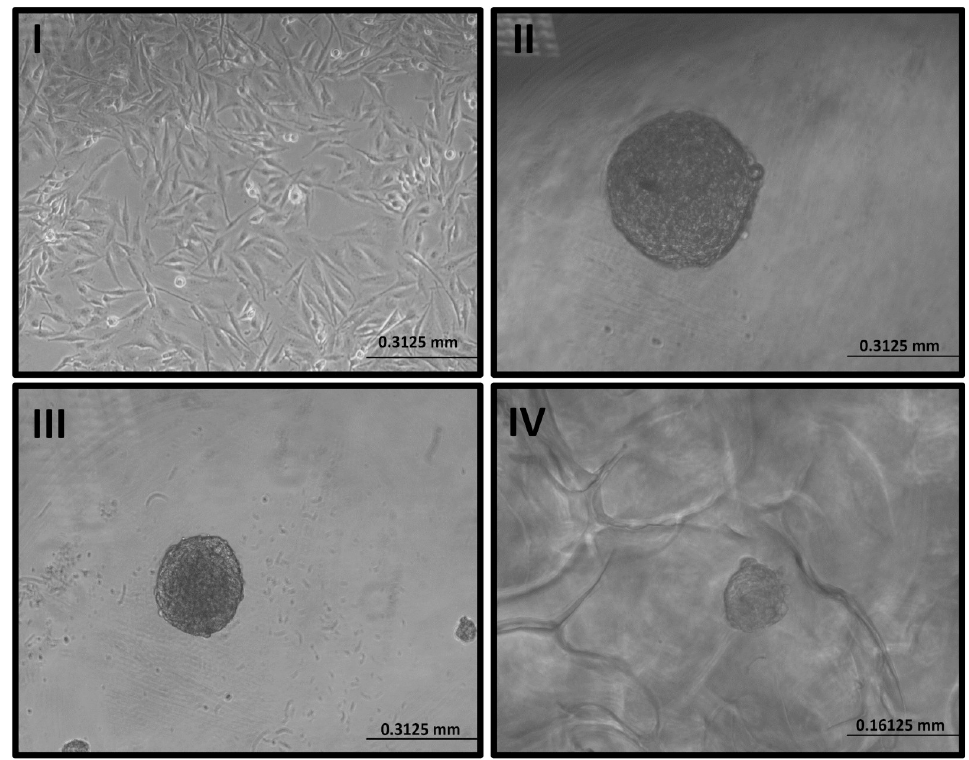
Fig 1. Development of U-251 MG human glioblastoma astrocytoma 3D in vitro cell culture model. I). Image of U- 251 MG 2D cells in T75 flask II) 3D tumoursphere constructed in low adhesion plate. III). 3D tumoursphere constructed in hanging drop plate. IV) 3D tumoursphere constructed in hydroxipropylcellulose scaffold. Tumour spheroid formation was visually confirmed using an Optika XDS-2 trinocular inverse microscope equipped with a Camera